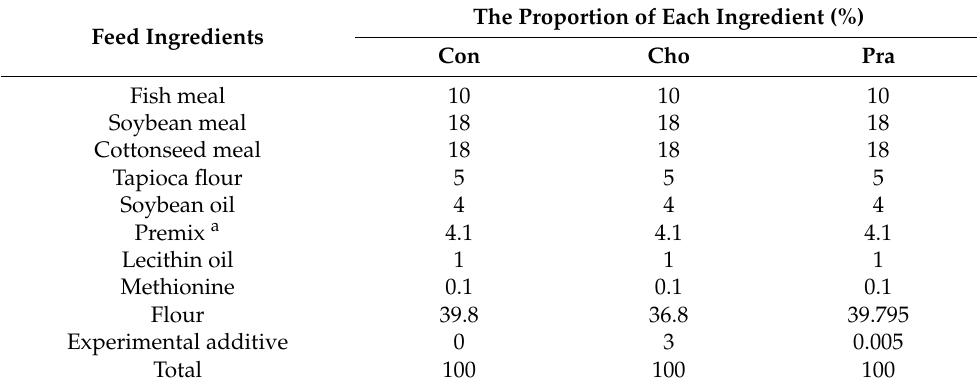
Table 1. Formulation and composition of experimental diets (%). Feed